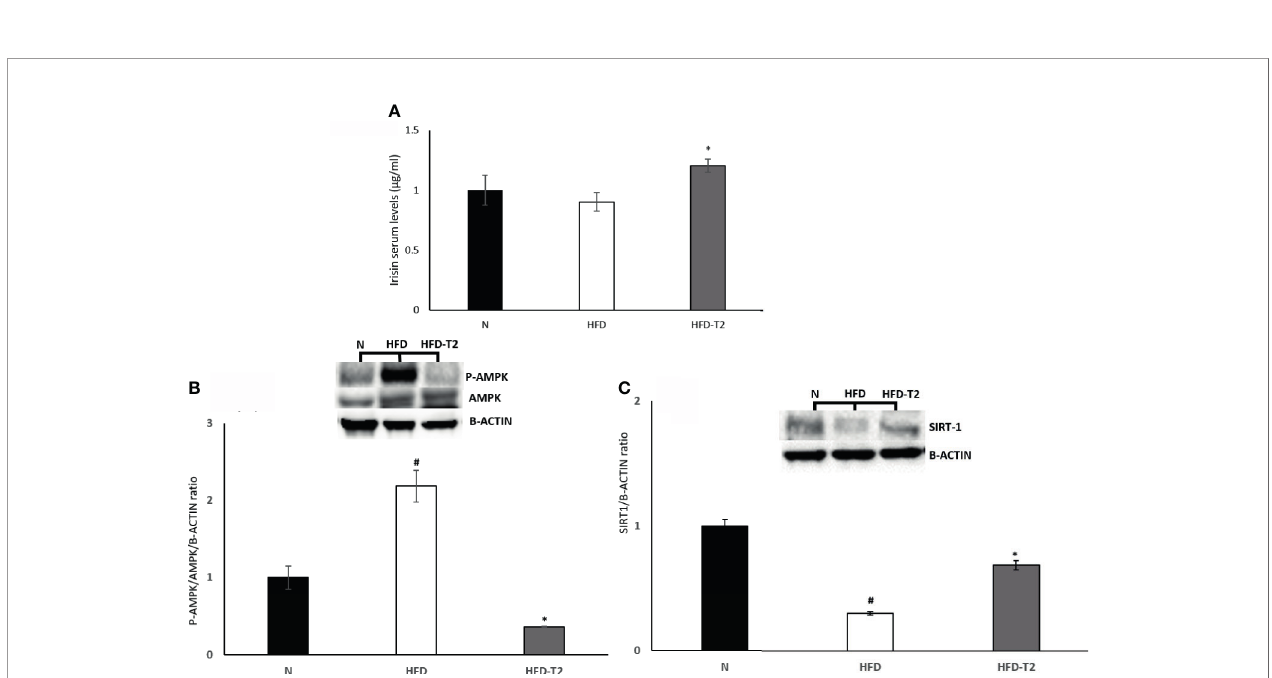
FIGURE 6 | Effects of T2 administration on Irisin serum levels and on P-AMPK and SIRT-1 expression in vWAT. (A) Irisin was detected by a competitive Enzyme Linked-Immunosorbent Assay (ELISA) in serum of N, HFD, HFD-T2 rats. The histograms represent means ± SEM of fi ve independent experiments (n=5), *P < 0.05 vs. HFD. N: rats receiving a standard diet for 14 weeks; HFD: rats receiving a HFD for 14 weeks; HFD-T2: rats receiving a HFD for 14 weeks with a daily administration of T2 during the last 4 weeks. (B, C) Western blot images and densitometry showing relative expression of P-AMPK and SIRT-1. The histograms represent means ± SEM of fi ve independent experiments (n = 5), # P < 0.05 vs. N; *p < 0.05 vs. HFD. N: rats receiving a standard diet for 14 weeks; HFD: rats receiving a HFD for 14 weeks; HFD-T2: rats receiving a HFD for 14 weeks with a daily administration of T2 during the last 4 weeks.